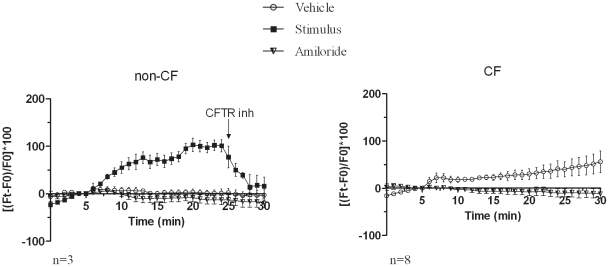
Amiloride inhibits the spontaneous depolarization signal detected in CF monocytes.Non-CF monocytes were analyzed with vehicle alone and in the presence of amiloride (left panel). Amiloride does not affect baseline. Amiloride treatment induces a reduction of spontaneous depolarization in CF subjects (right panel) to an extent overlapping to the effect of the addition of the stimulus. The effect of CFTR (inh)-172 after 15 minutes after addition of the stimulus in non-CF monocytes is also shown (left).